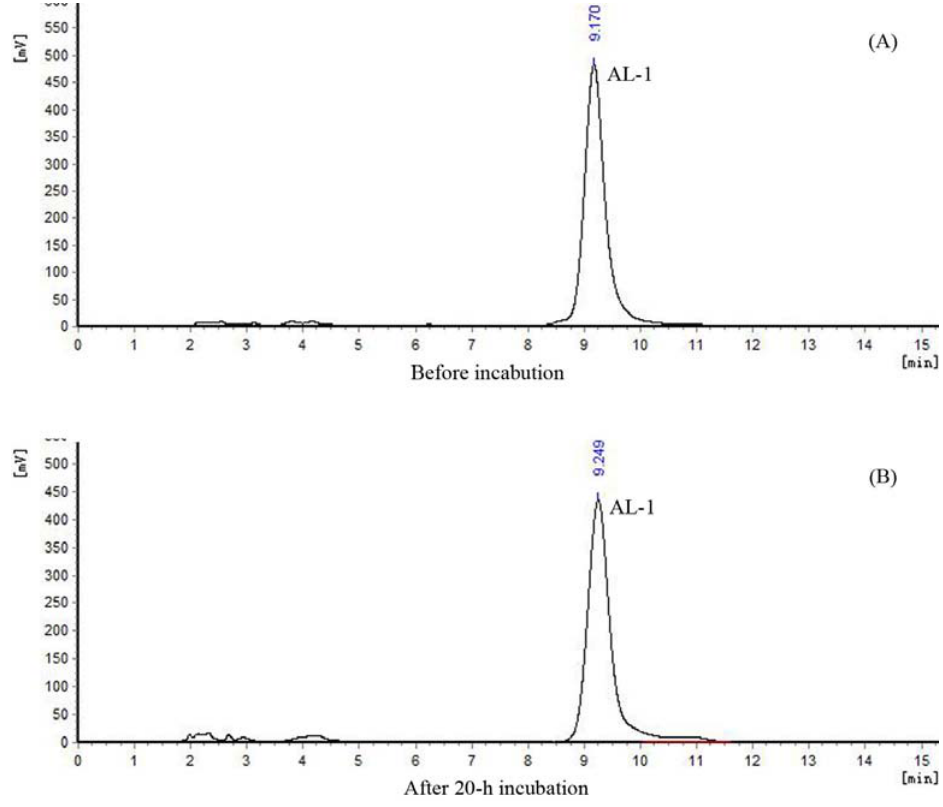
Figure 2. HPLC chromatograms of AL-1 and Andro in the absence of